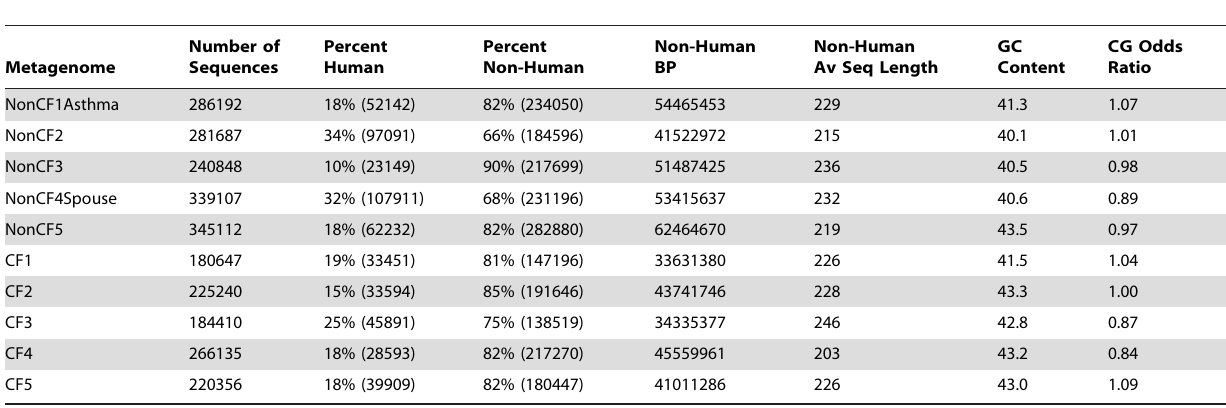
Table 2. Characteristics of the 10 human respiratory tract viral metagenomes including GC content and CG dinucleotide relative abundance odds